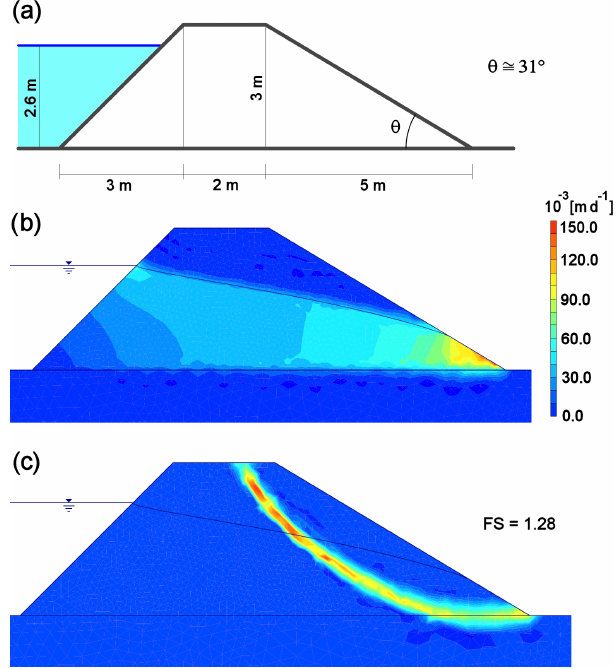
Figure 7. (a) Cross-sectional sketch of a stable dam with the main elements dimension, (b) water velocity field moving in the dam body and associated phreatic surface, and (c) breaking surface gen- erated by a factor of safety of